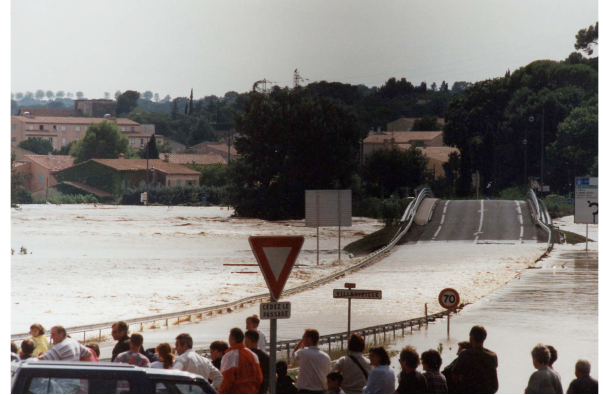
Figure 8. Example of a submerged access road to the river crossing structure located in the Fig. 8. Example of a submerged access road to the river crossing flood plain (Gard 2002 flood upstream the town of Sommières) structure located in the flood plain (Gard 2002 flood upstream the town of